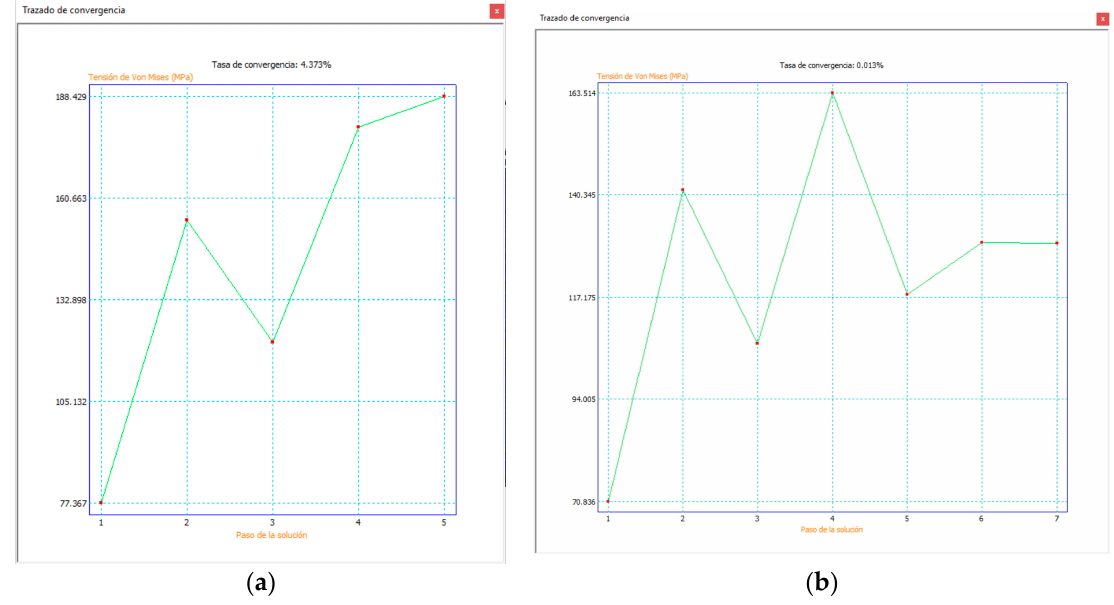
Figure 13. Convergence curve: ( a ) downward movement and ( b ) upward movement.